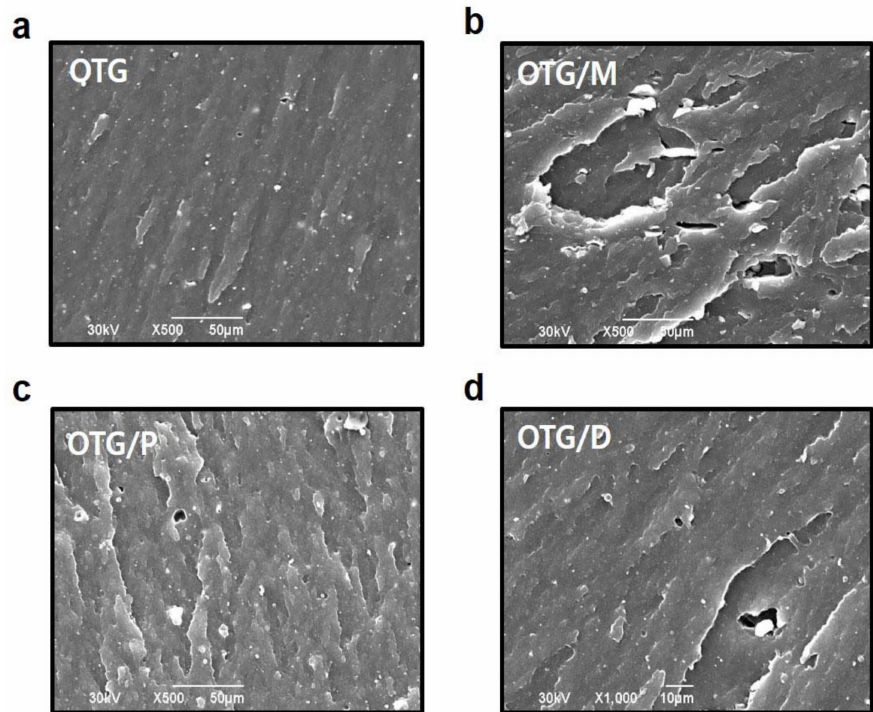
Figure 4. Scanning electron microscope (SEM) images of elastomer composites. ( a ) SEM images of the fracture surfaces of the elastomer composites with OTG. ( b ) SEM images of the fracture surfaces of the elastomer composites with OTG/M. ( c ) SEM images of the fracture surfaces of the elastomer composites with OTG/P. ( d ) SEM images of the fracture surfaces of the elastomer composites with